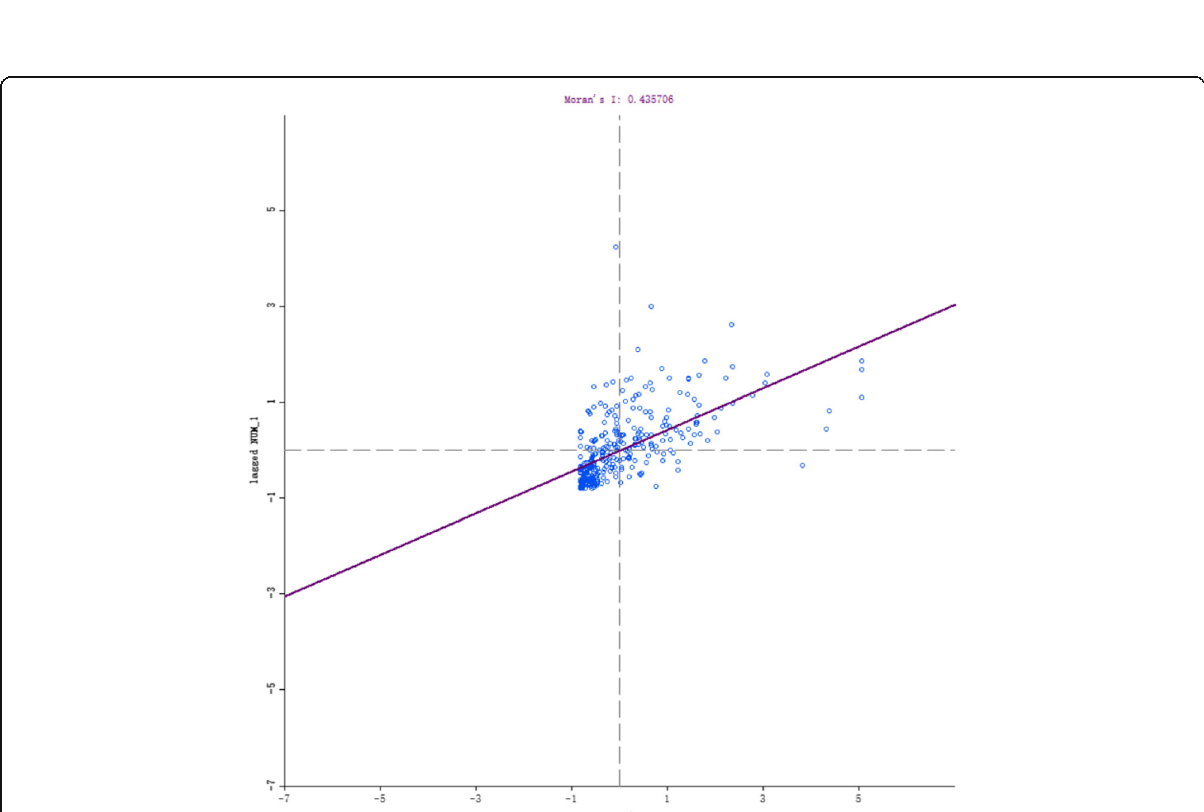
Fig. 9 Spatial correlation description of traffic